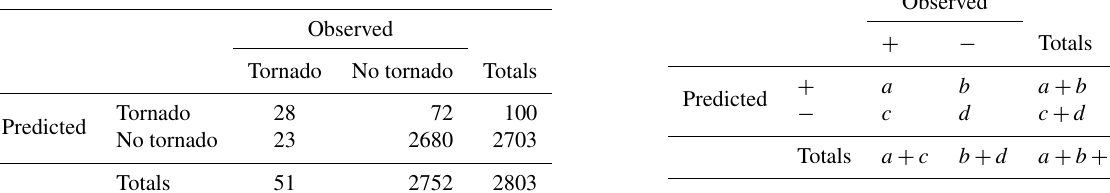
Table 1. Finley’s consolidated tornado predictions March– May 1884, after Gilbert (1884).